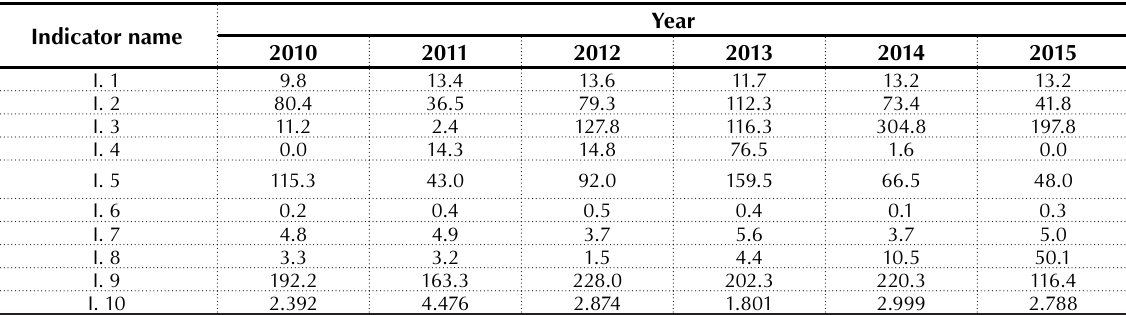
Source: State Statistics Service of Ukraine (2018).